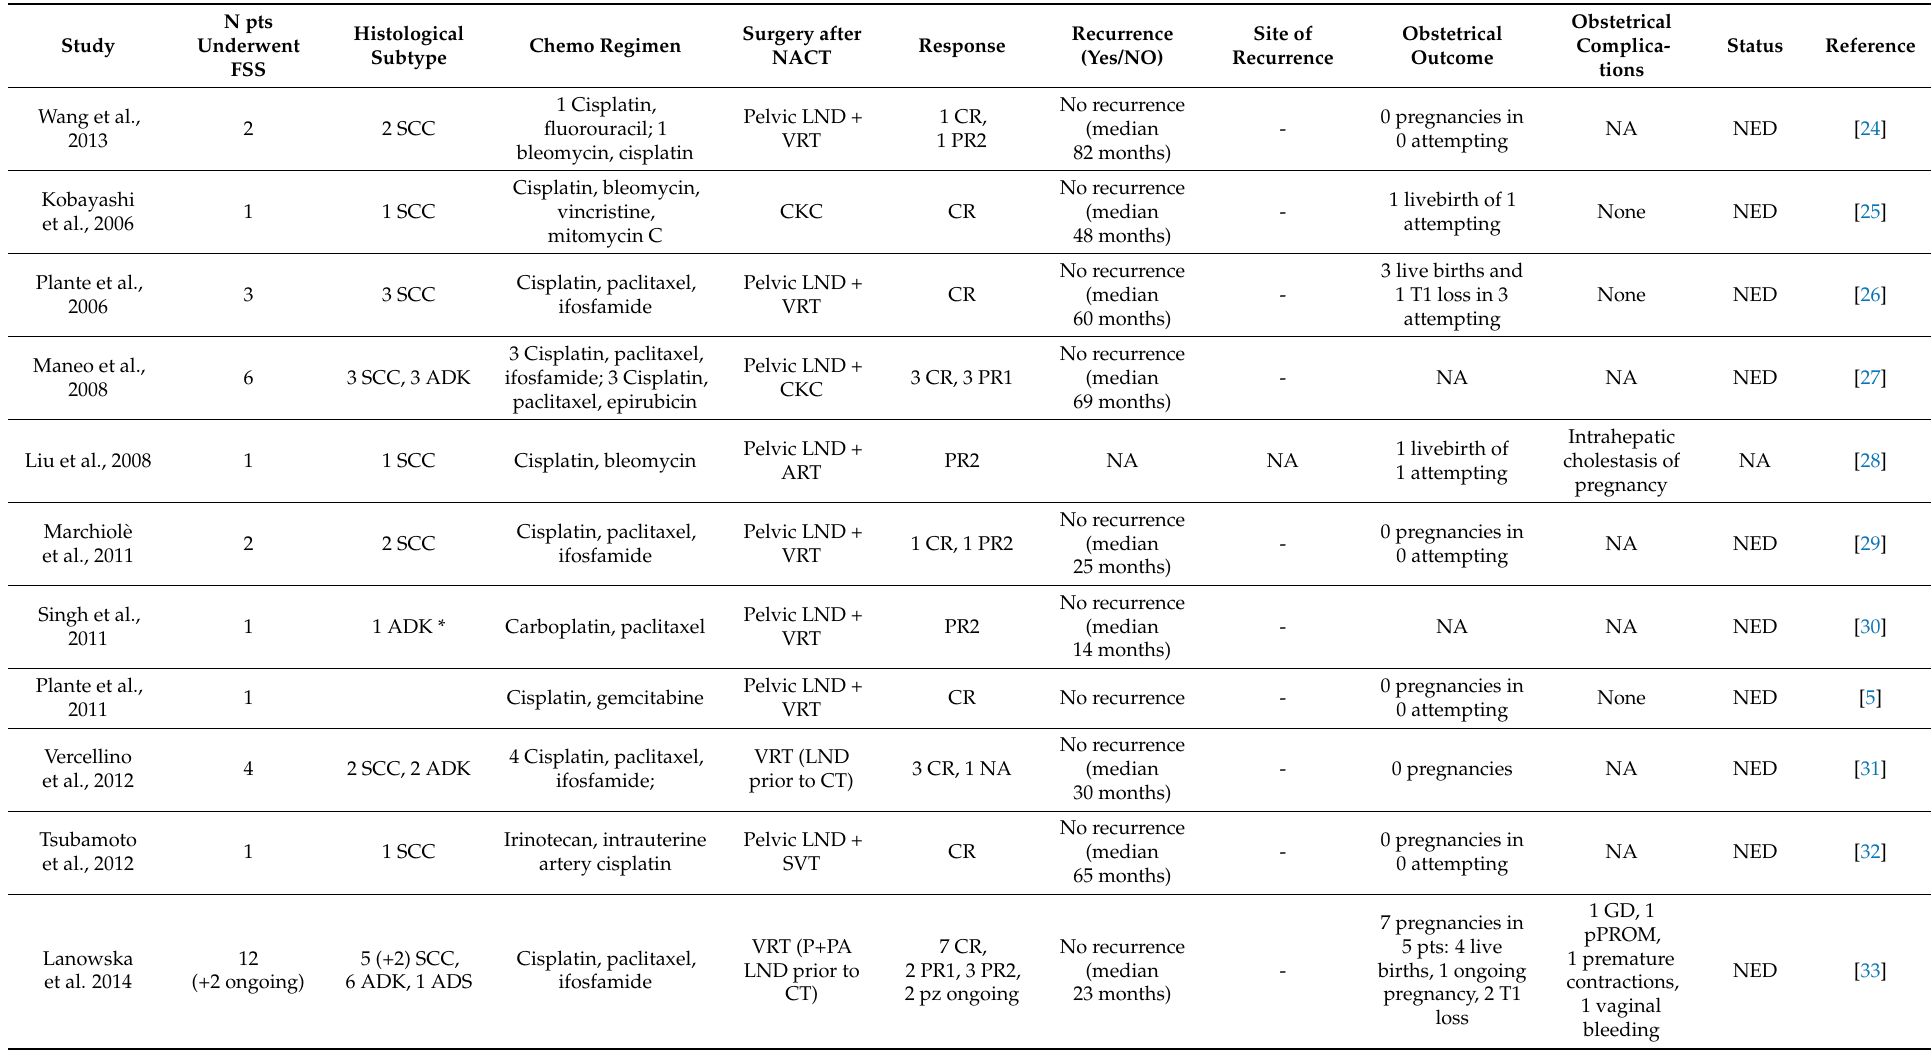
Table 1. Studies of neoadjuvant chemotherapy with conservative management for stage IB2 cervical